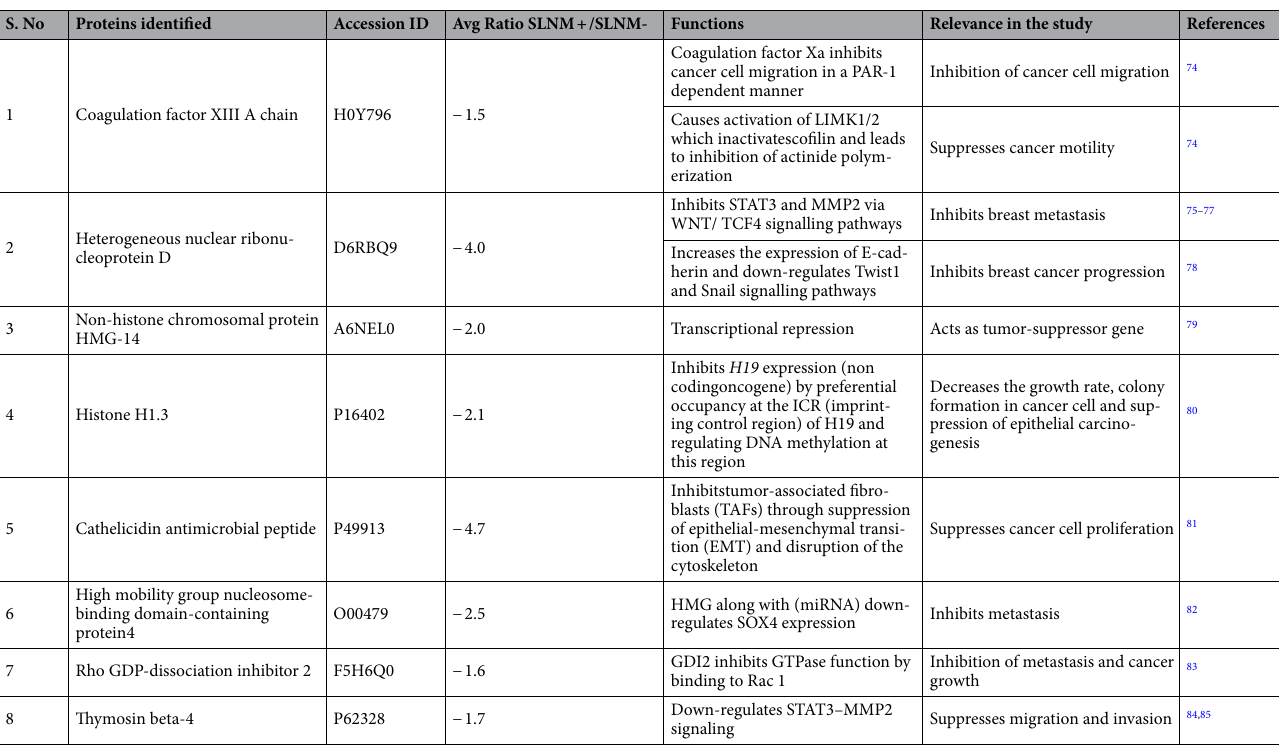
Table 3. Proteins down-regulated in tissue of sentinel lymph node metastasis as compared to sentinel lymph node without